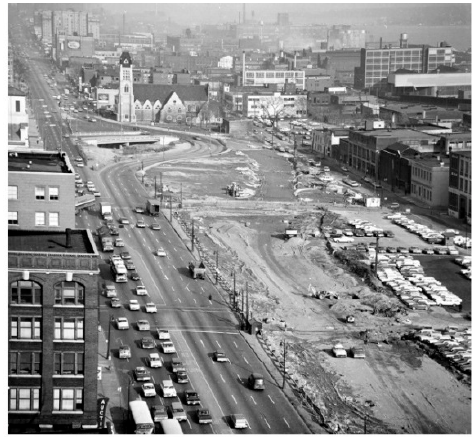
Figure 3. Unknown, 1950’s. An aerial view of Detroit during the era of Urban Renewal. Courtesy WDET.